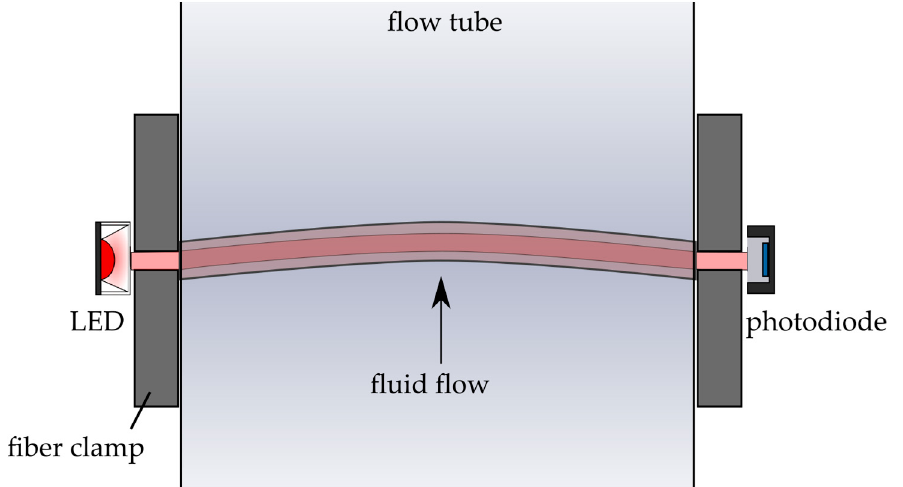
Figure 4. Schematic description of the sensor and the sensor mechanism in the presence of fluid flow. The fiber is integrated into a flow tube while fixed on each side with fiber clamps. Fluid flow bends the waveguide and the light intensity at the output decreases.